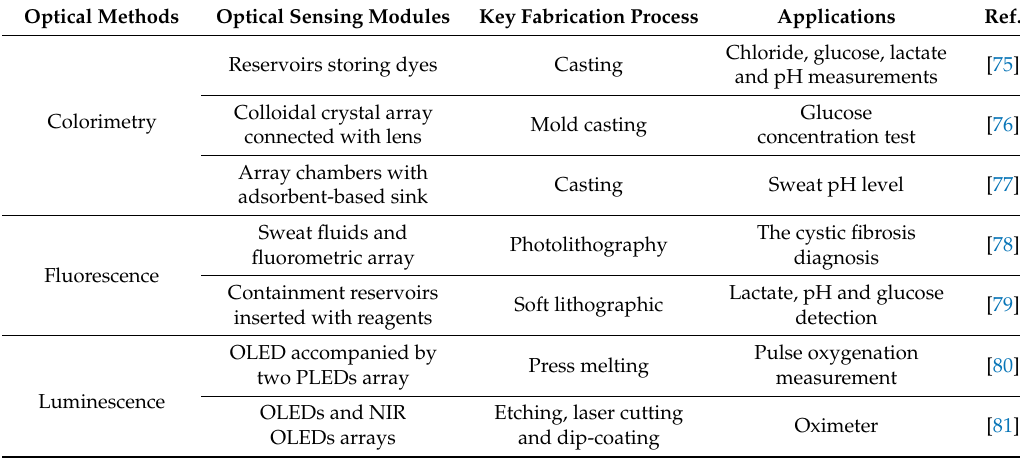
Table 4. Integrated wearable optical devices for